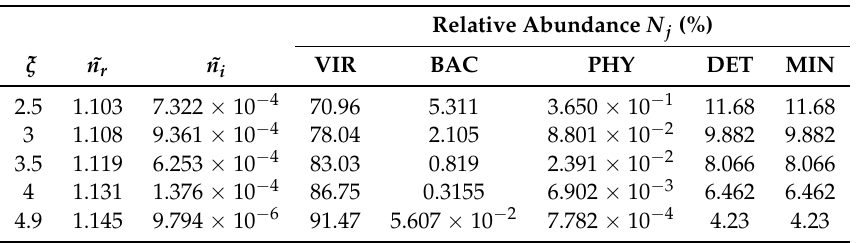
Table 5. Relative abundance of viruses (VIR), bacteria (BAC), phytoplankton (PHY), and organic detritus (DET) with the corresponding bulk refractive index (Equations (9) and (10)) for waters with minerals and no bloom conditions (coastal-like).